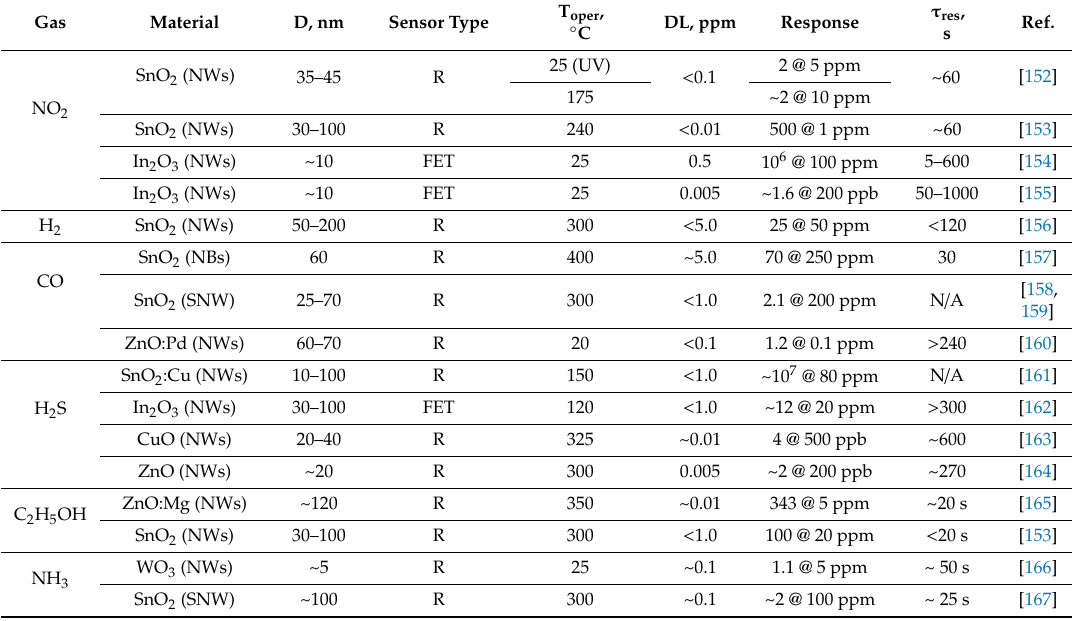
Figure 9. Position of ( a ) nanowires or nanotubes and ( b ) nanobelts on the contact pad. Reproduced with permission from Korotcenkov [74]. Copyright 2008: Elsevier. Table1.